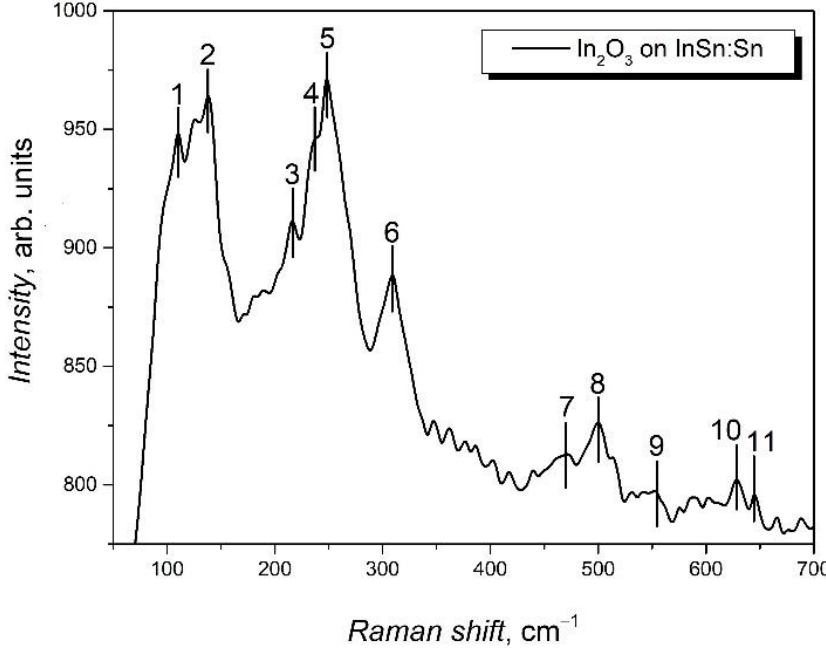
Figure 2. Raman spectrum of the In 2 O 3 layer obtained by 6 h heat treatment in air, at 600 ◦ C, of single-crystalline InSe plates doped with Sn (InSe:Sn/In 2 O 3 structures). Table 1. Raman frequencies of the In 2 O 3 layer obtained by heat treatment in air, at 600 ◦ C, for 6 h, of single-crystalline InSe plates doped with Sn (InSe:Sn/In 2 O 3 structures), compared to those in In 2 O 3 and